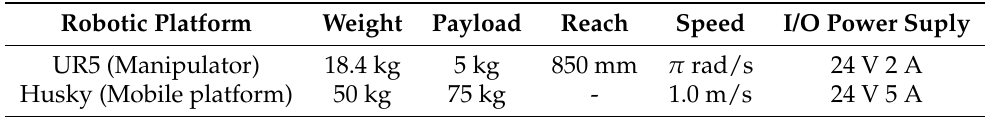
Table 2. Robotic platforms: main features UR5 and Husky. Robotic